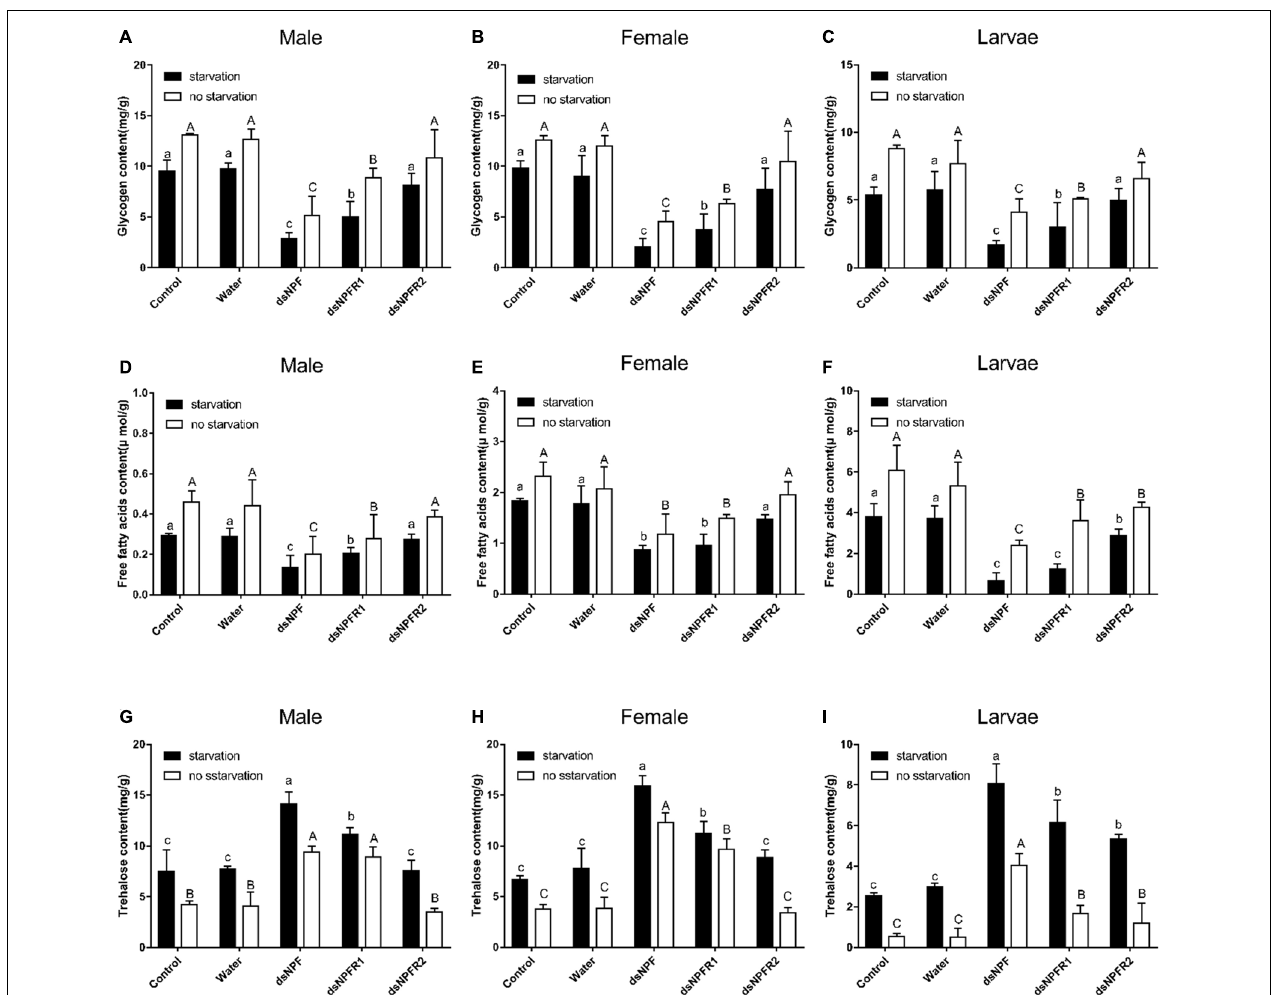
FIGURE 7 | Effect of dsNPF, dsNPFR1, and dsNPFR2 on energy metabolism of D. armandi . Samples were collected and assayed at 72 h after injection. Whole-body homogenates were used to measure glycogen of male (A) , female (B) , and larvae (C) , Free fatty acids of male (D) , female (E) , and larvae (F) and trehalose contents of male (G) , female (H) , and larvae (I) in the state of starvation and non-starvation. Different letters indicate significant differences at the 0.05 level (uppercase for non-starvation, lowercase for starvation). All values are mean ± SE , n =